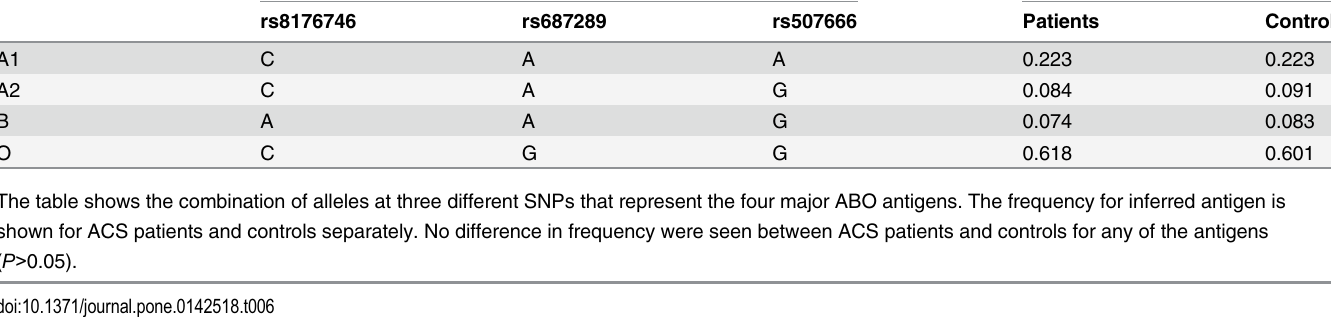
Table 6. Frequencies of haplotypes representing the different ABO antigen alleles in ACS patients and controls. ABO allele